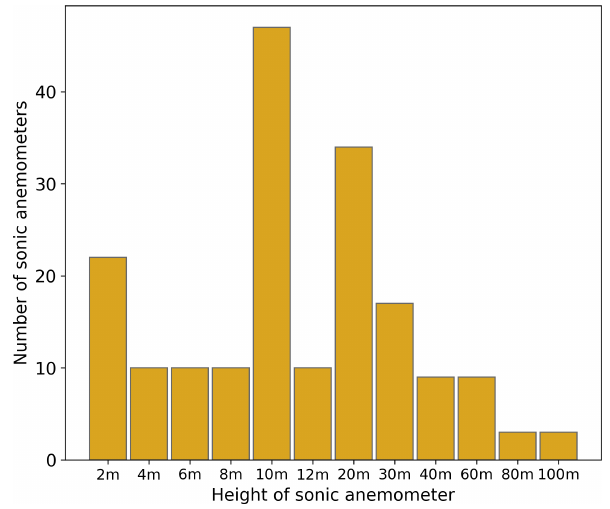
Figure 2. Histogram of the heights a.g.l. of the 184 sonic anemome- ters considered in this